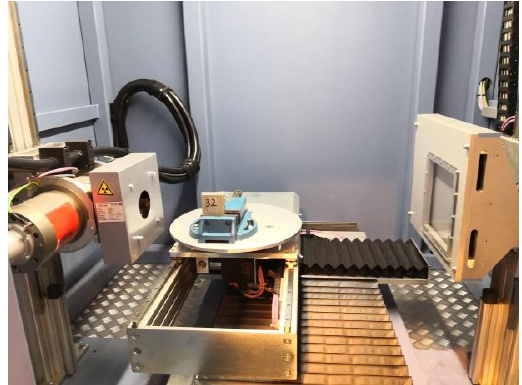
Figure 3. Radiographic